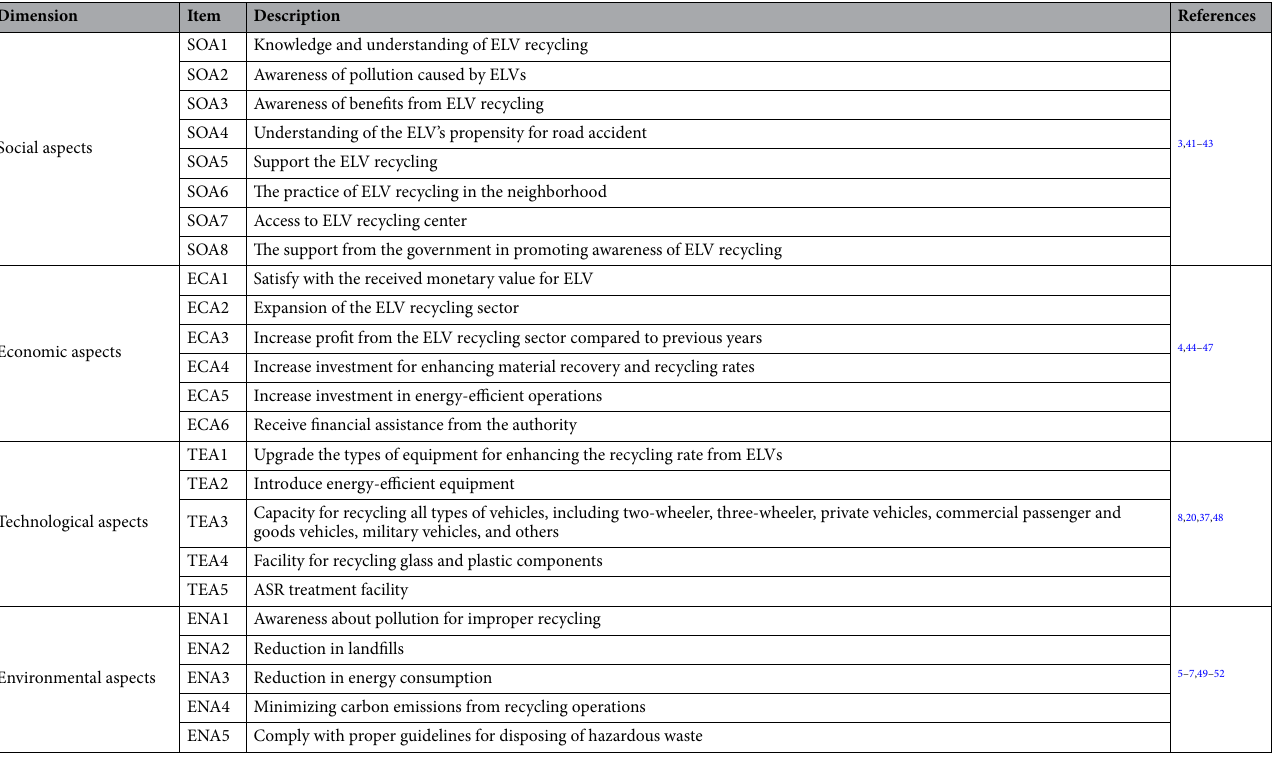
Table 2. The questionnaire items for evaluating sustainability from techno-socio-economic and environmental